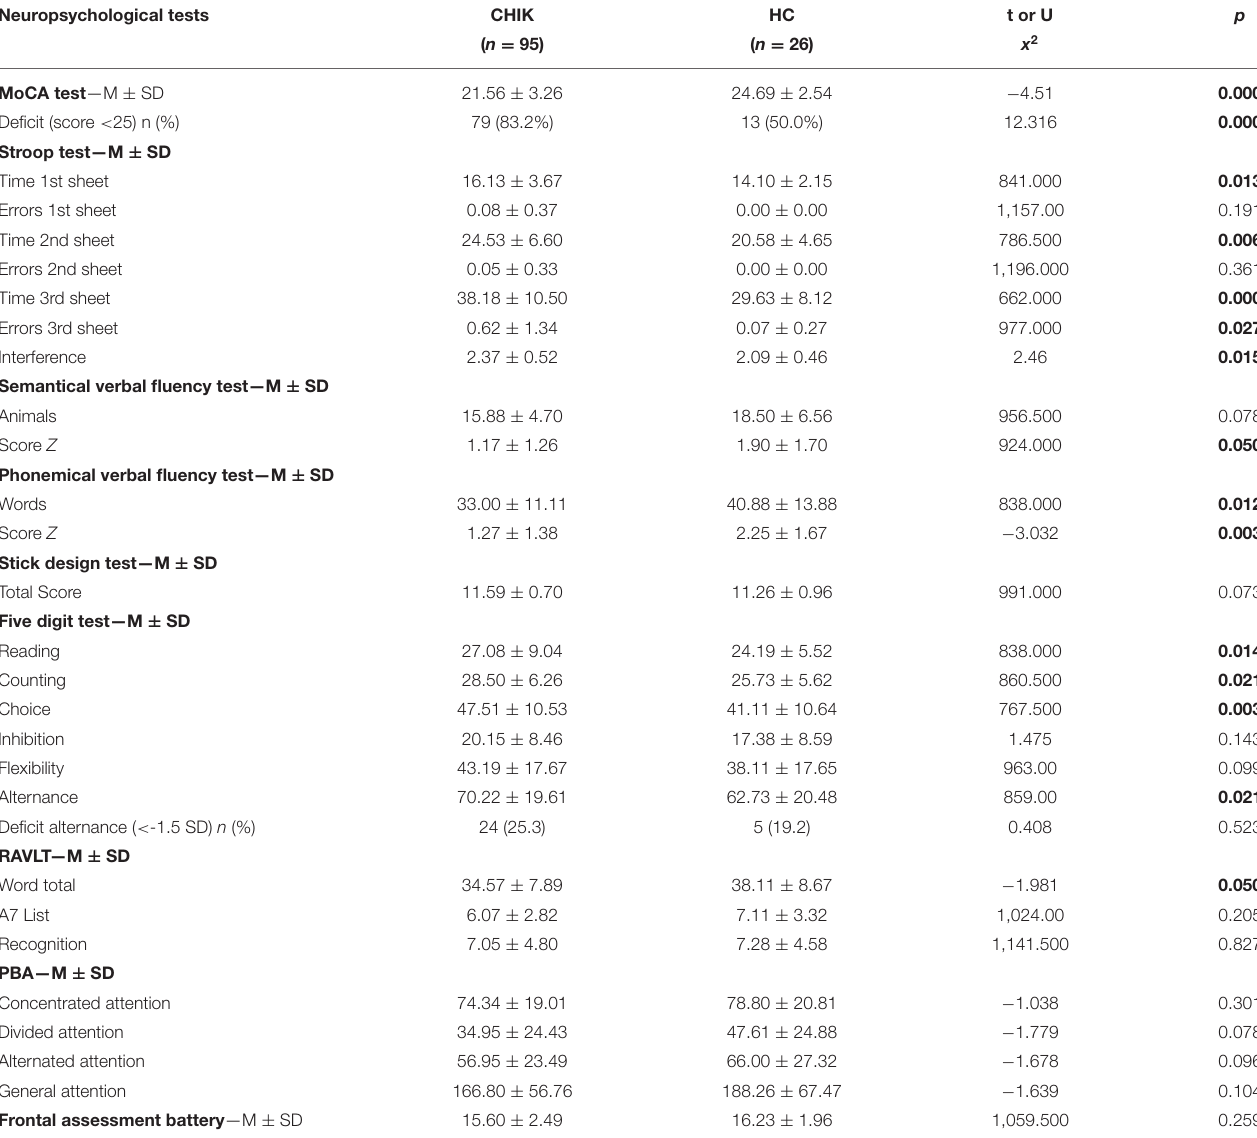
TABLE 2 | Raw neuropsychological tests results and the respective impairment (tests results < -1.5 SD) by groups (CHIK and healthy controls). Neuropsychological